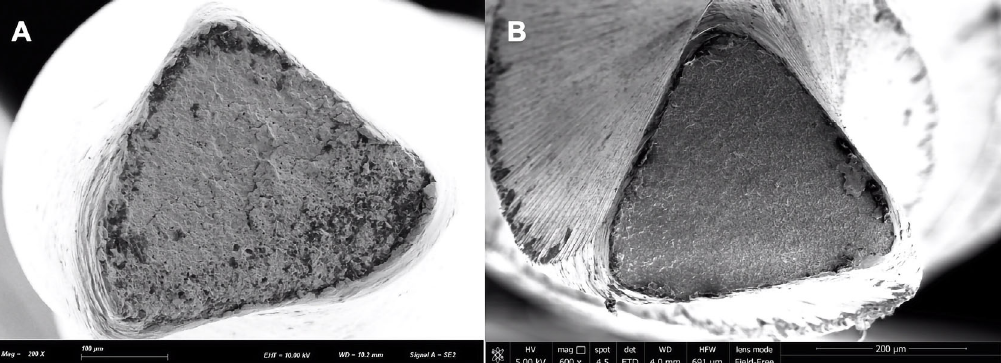
Figure 2. ( A , B ) The scanning electron microscope (SEM) images of the cross ‐ sections of the tested